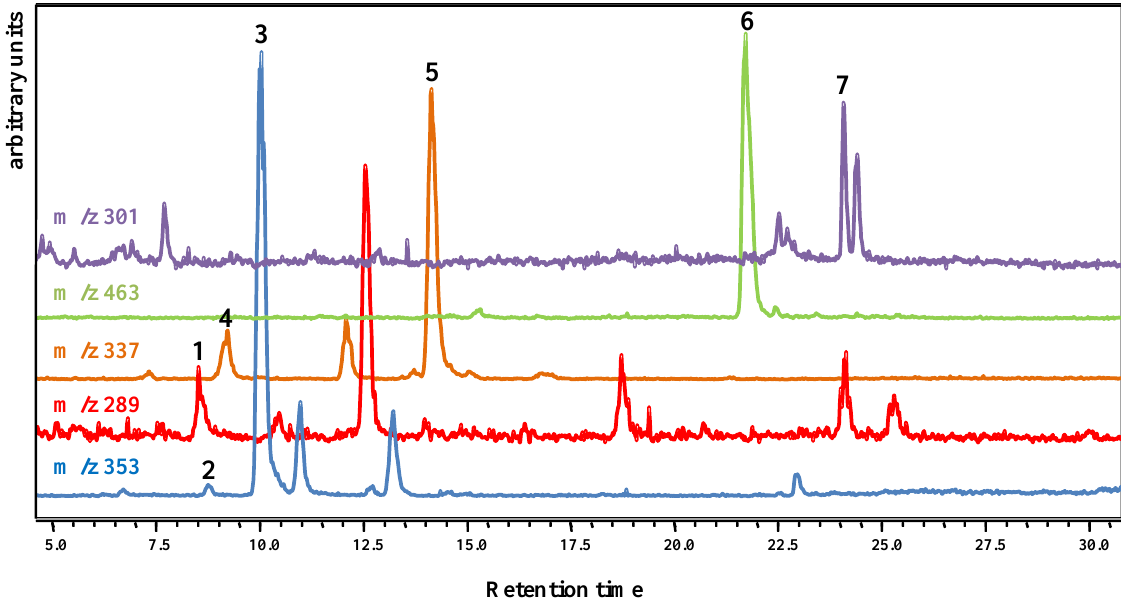
Figure 3. HPLC-MS chromatogram of the phenolic compounds of the honey mixed beverage. The compounds identified were catechin (1; m / z = 289), 4-caffeoylquinic acid (2; m / z = 353), 5-caffeoylquinic acid (3; m / z = 353), p -coumaroylquinic acid isomer 1 (4; m / z = 337), p -coumaroylquinic acid isomer 2 (5; m / z = 337), quercetin-3- O -glucoside (6; m / z = 463), and quercetin (7; m / z = 301).